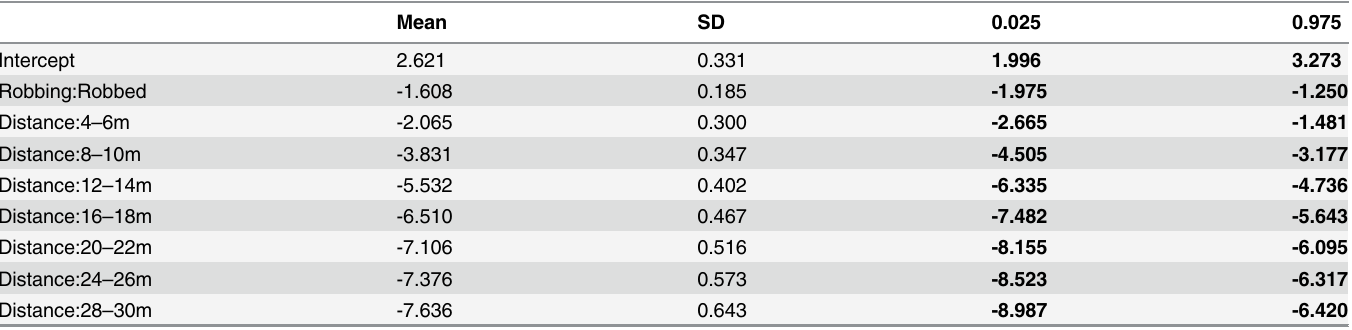
Table 1. Effect of striped-squirrel robbing behaviour on pollen dispersal at various distances. Distances represent 2 m intervals from the focal point. Mean SD 0.025 0.975 Intercept 2.621 0.331